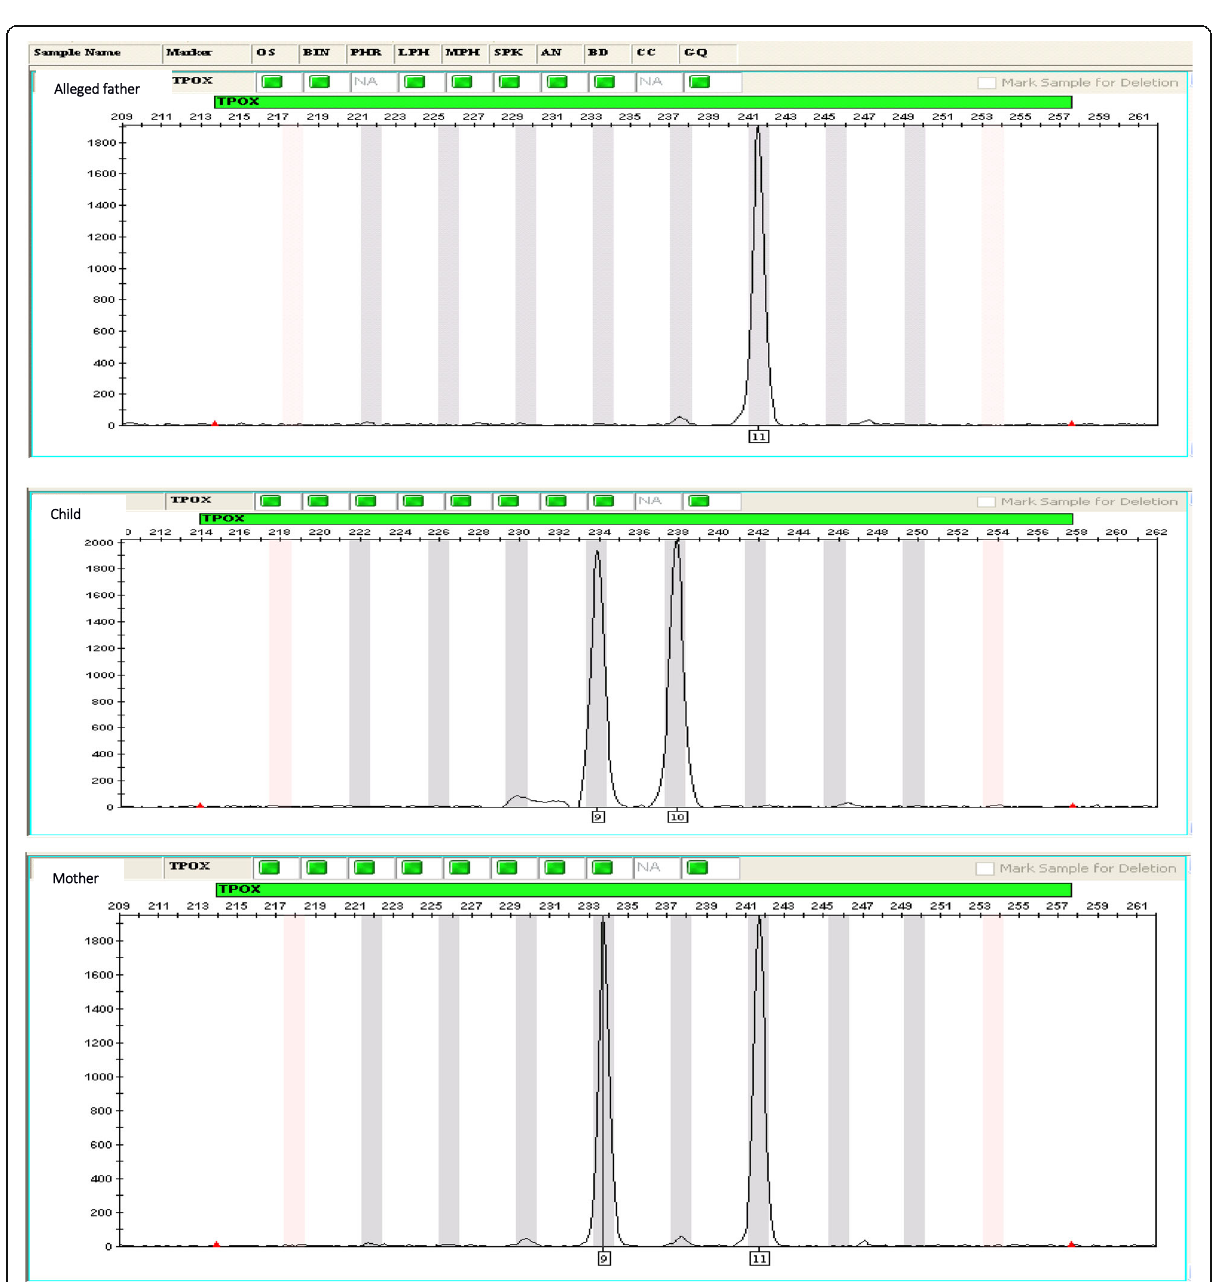
Fig. 2 Exclusion of paternity for the trio 2: example of allele no correspondence between alleged father and child for the locus TPOX